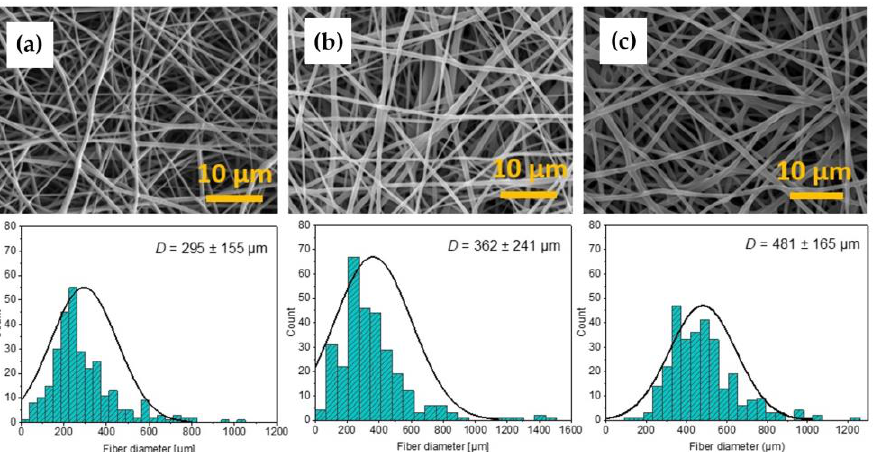
Figure 2. SEM images of the neat PLA/PHB/ATBC ( a ), PLA/PHB/ATBC + 5% oregano EO, ( b ) and PLA/PHB/ATBC + 5% lemongrass oil ( c ) fibers and matching histograms of fiber diameter distribu- tion.